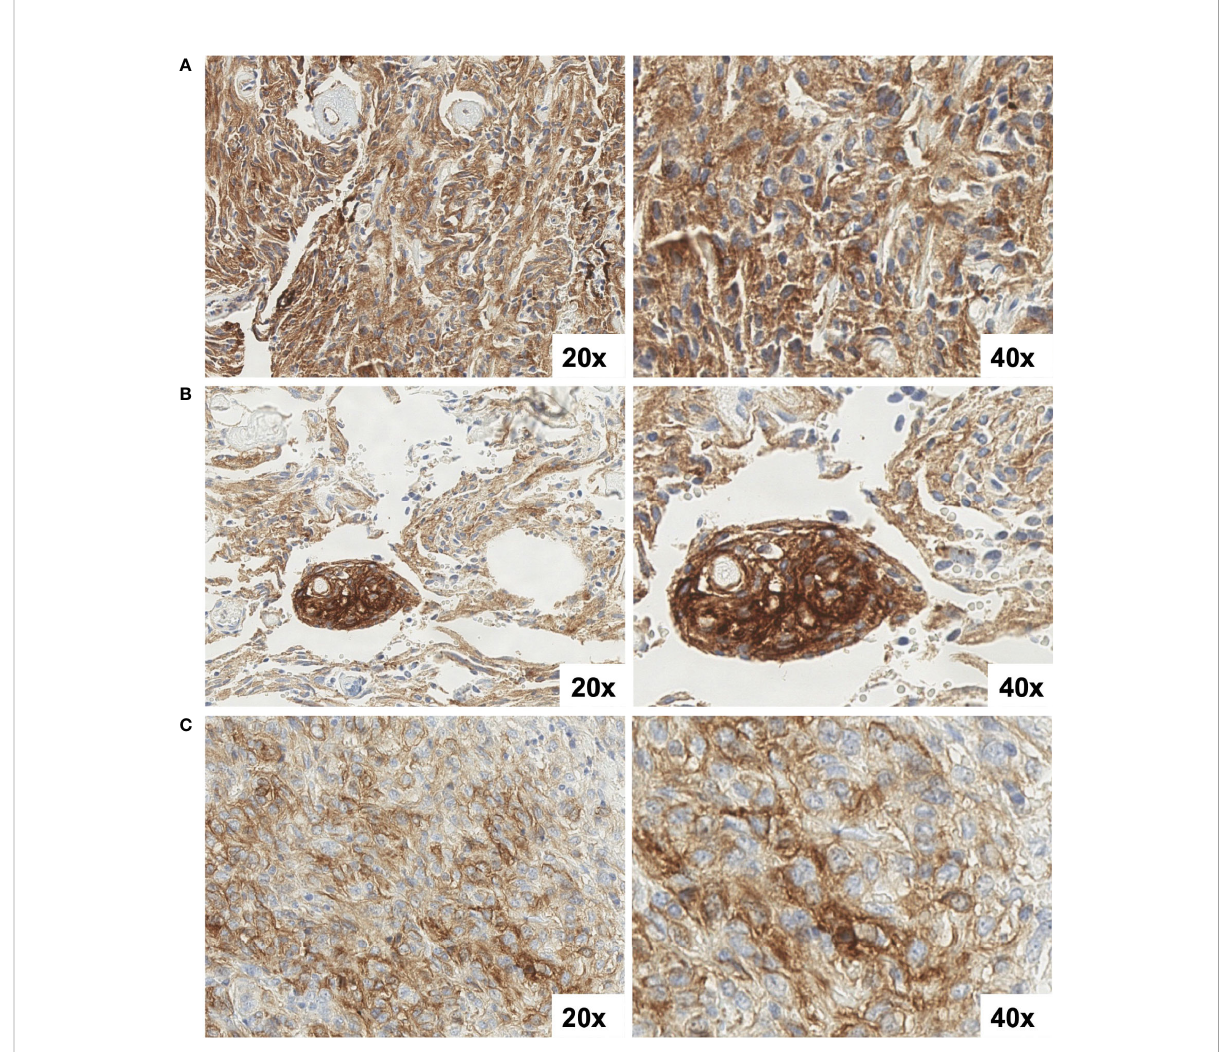
FIGURE 6 SST2A IHC images of a multiply recurrent atypical meningioma from three time-points: (A) initial diagnosis, prior to treatment, (B) post- radiation, fi ve years after diagnosis, and (C) following re-irradiation two years later (C) . All specimens demonstrated 10-20% tumor cell immunoreactivity and intratumoral heterogeneous staining intensity, ranging from light to strong. Non-speci fi c background staining is also observed. All images are shown at 20x and 40x magni fi